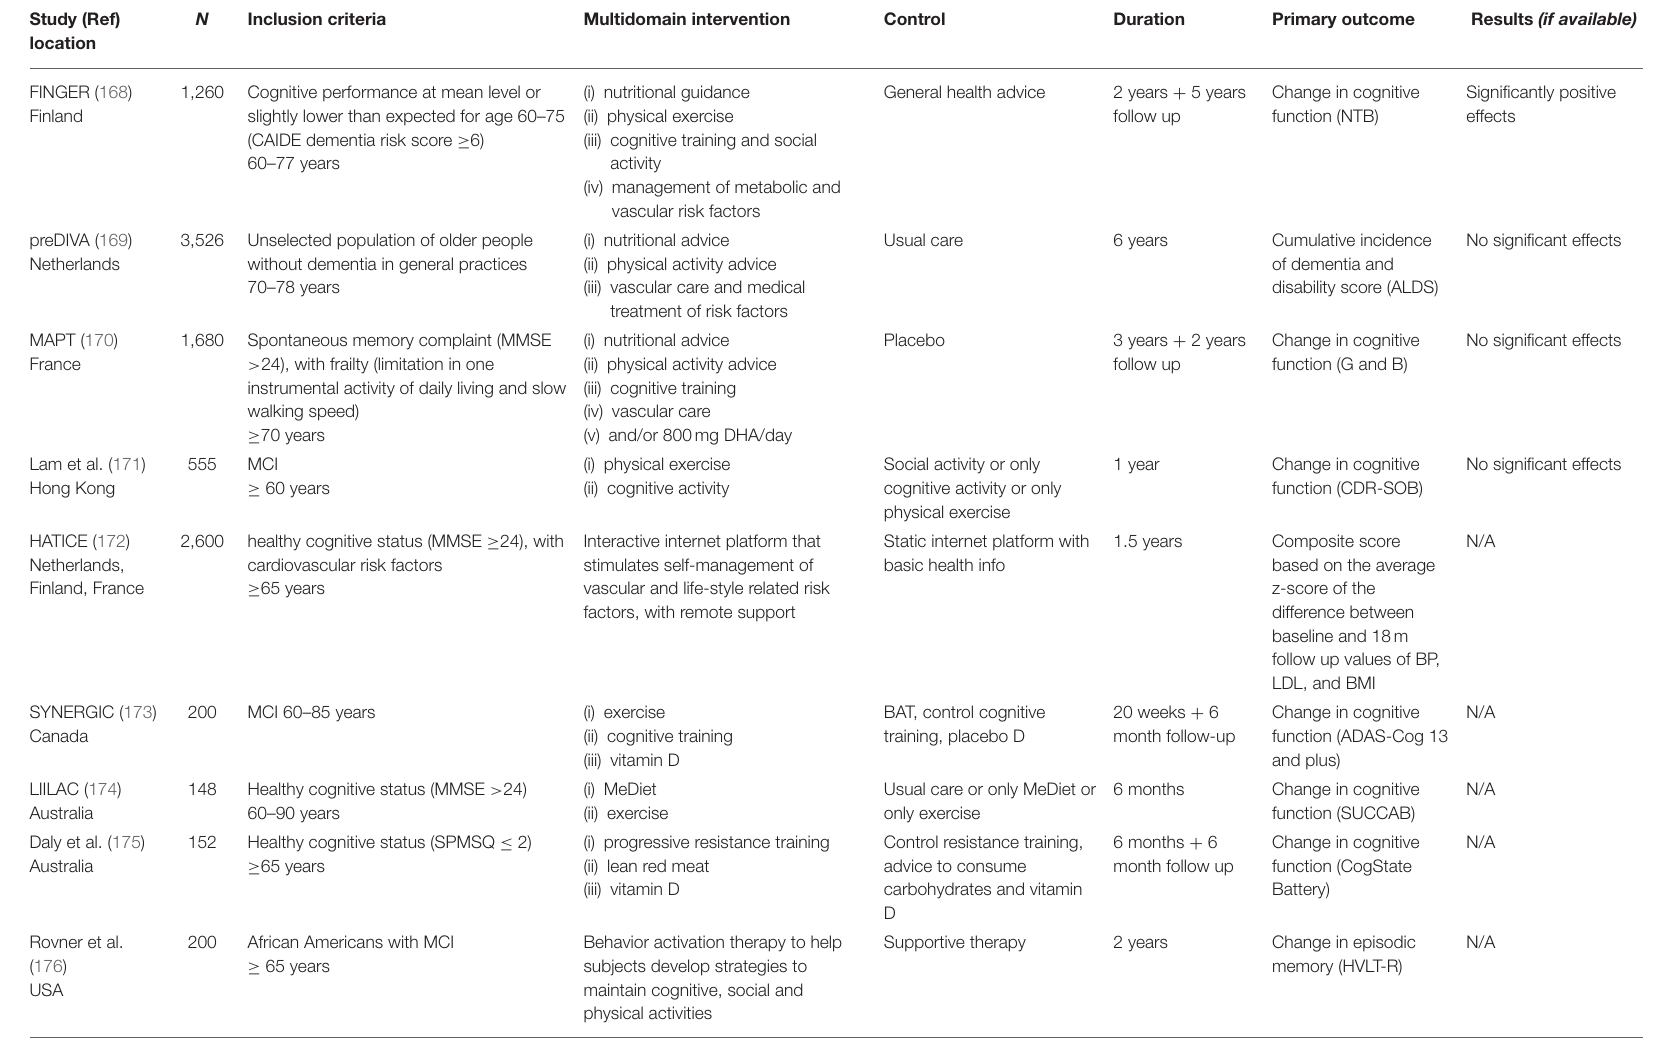
TABLE 2 | RCTs of multidomain lifestyle interventions for prevention of cognitive impairment, Alzheimer’s disease, and dementia. Study (Ref)